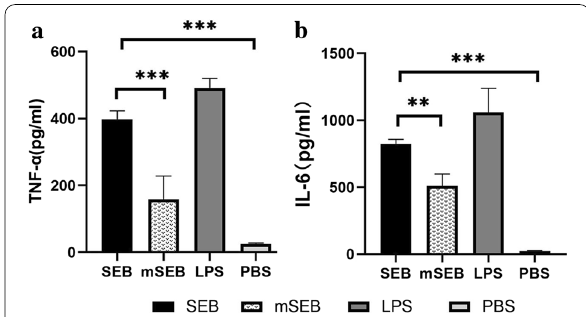
Fig. 4 Detection of TNF-a and IL-6 level in macrophage stimulated with mSEB and SEB. Cytokine was determined using ELISA after 24 h coculture of human macrophage with SEB, mSEB and LPS a TNF-alevel, b IL-6 level. * p < 0.05, ** p < 0.01. *** p <